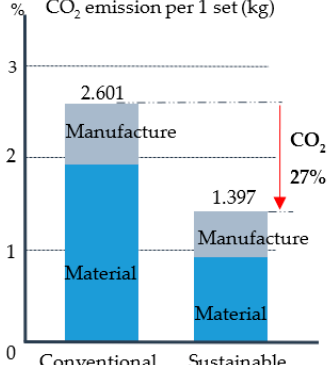
Figure 23. Carbon dioxide (CO ₂ ) reduction.